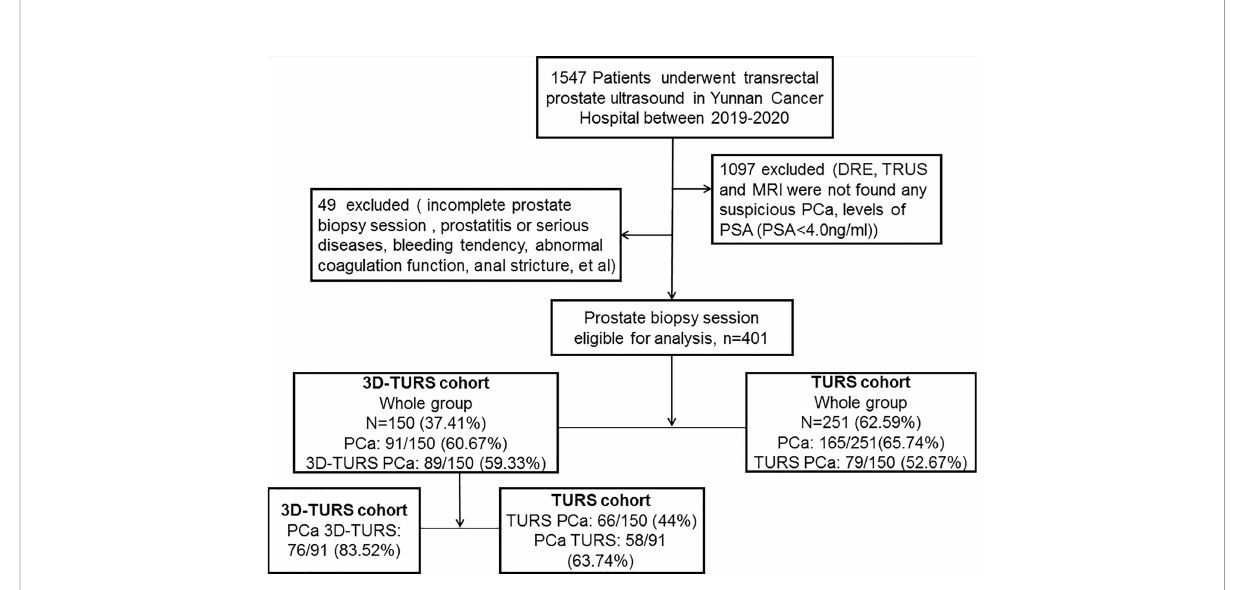
FIGURE 1 Flow chart for prostatic cancer patients of 3D-TRUS cohort and TRUS